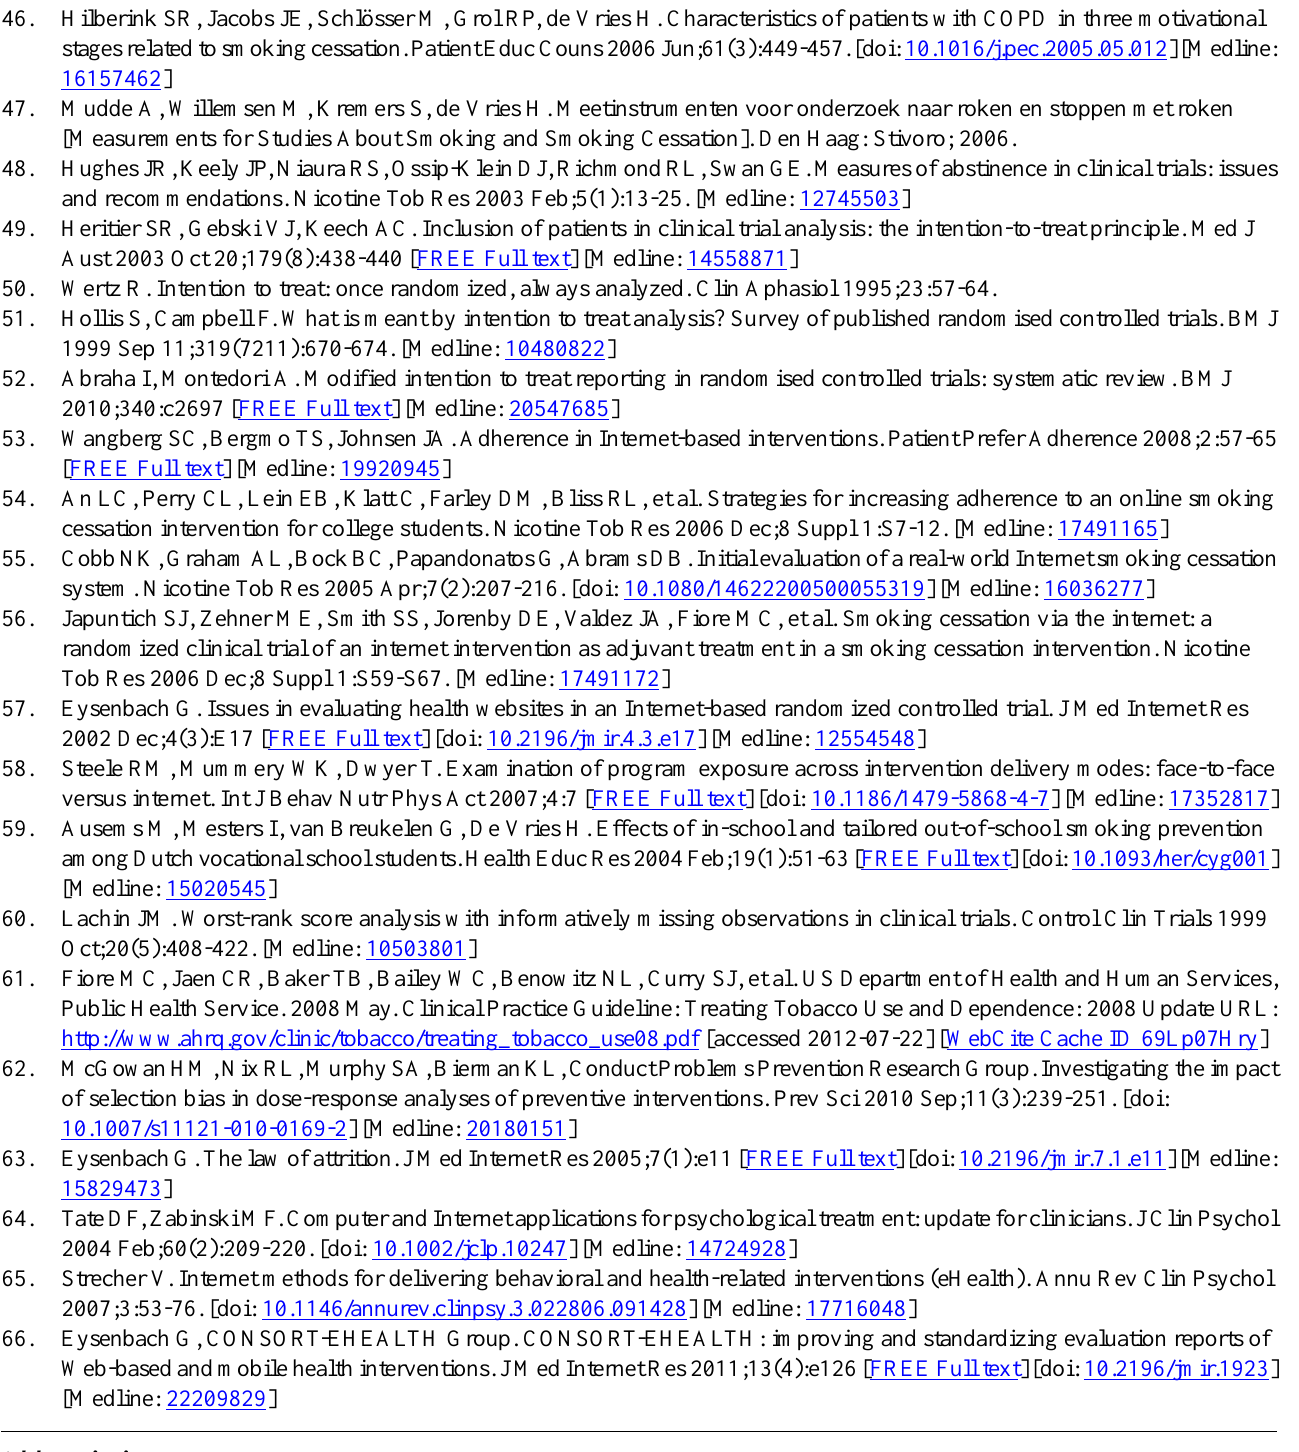
Abbreviations AP: Action planning (program) AP+: Action planning plus (program) CI: confidence interval I-Change Model: Integrated Change Model OR: odds ratio SQ4U: Stay Quit for